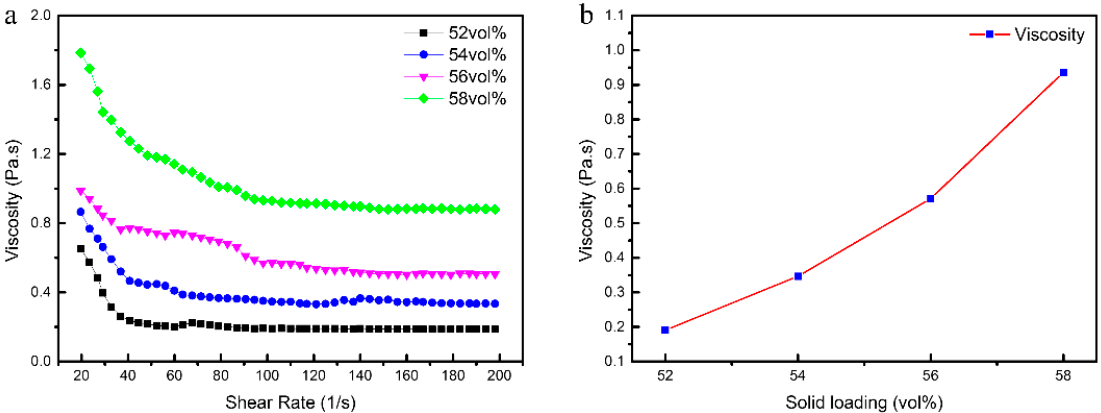
Figure 4. Effect of solid loading on the viscosity of CaO slurries at ( a ) different shear rates and ( b ) 100 s − 1 shear rate.